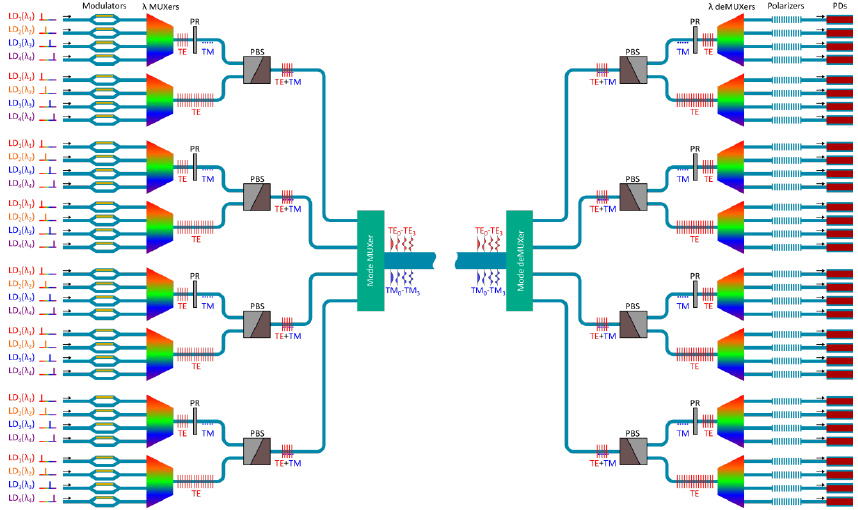
Figure 9. A proposal for the scalable WDM / polarization-division multiplexing (PDM) / MDM hybrid systems.